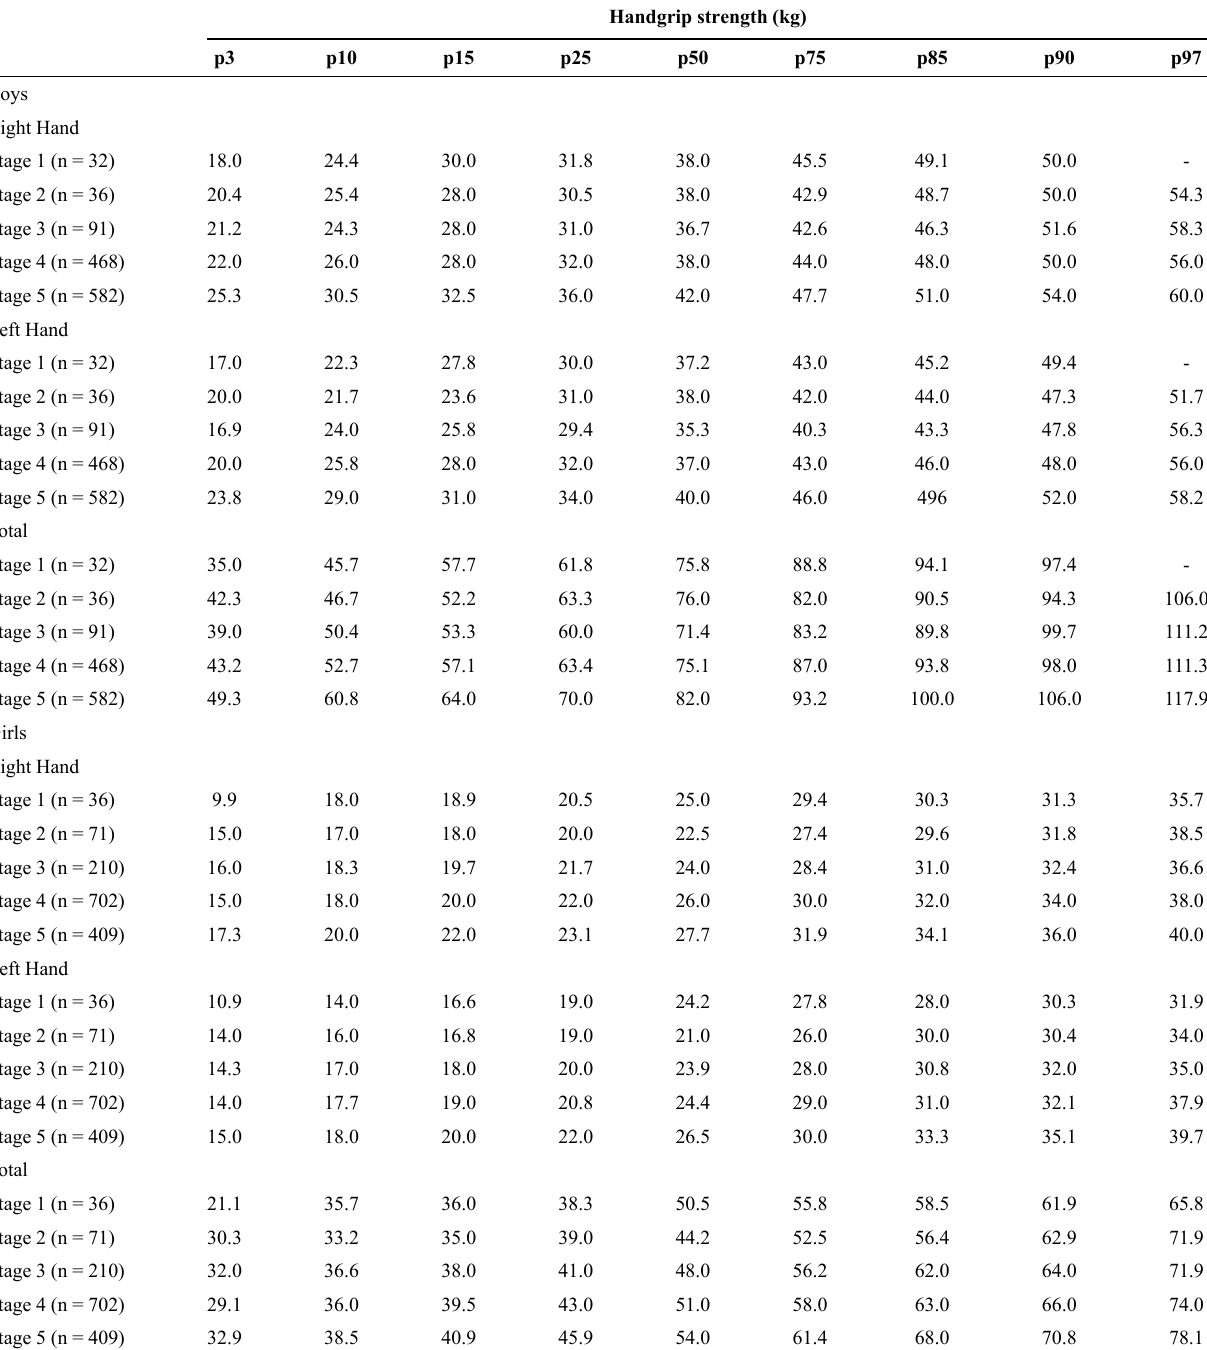
Table 3 - Normative HGS values for adolescents of both sexes, according to sexual maturation stage.